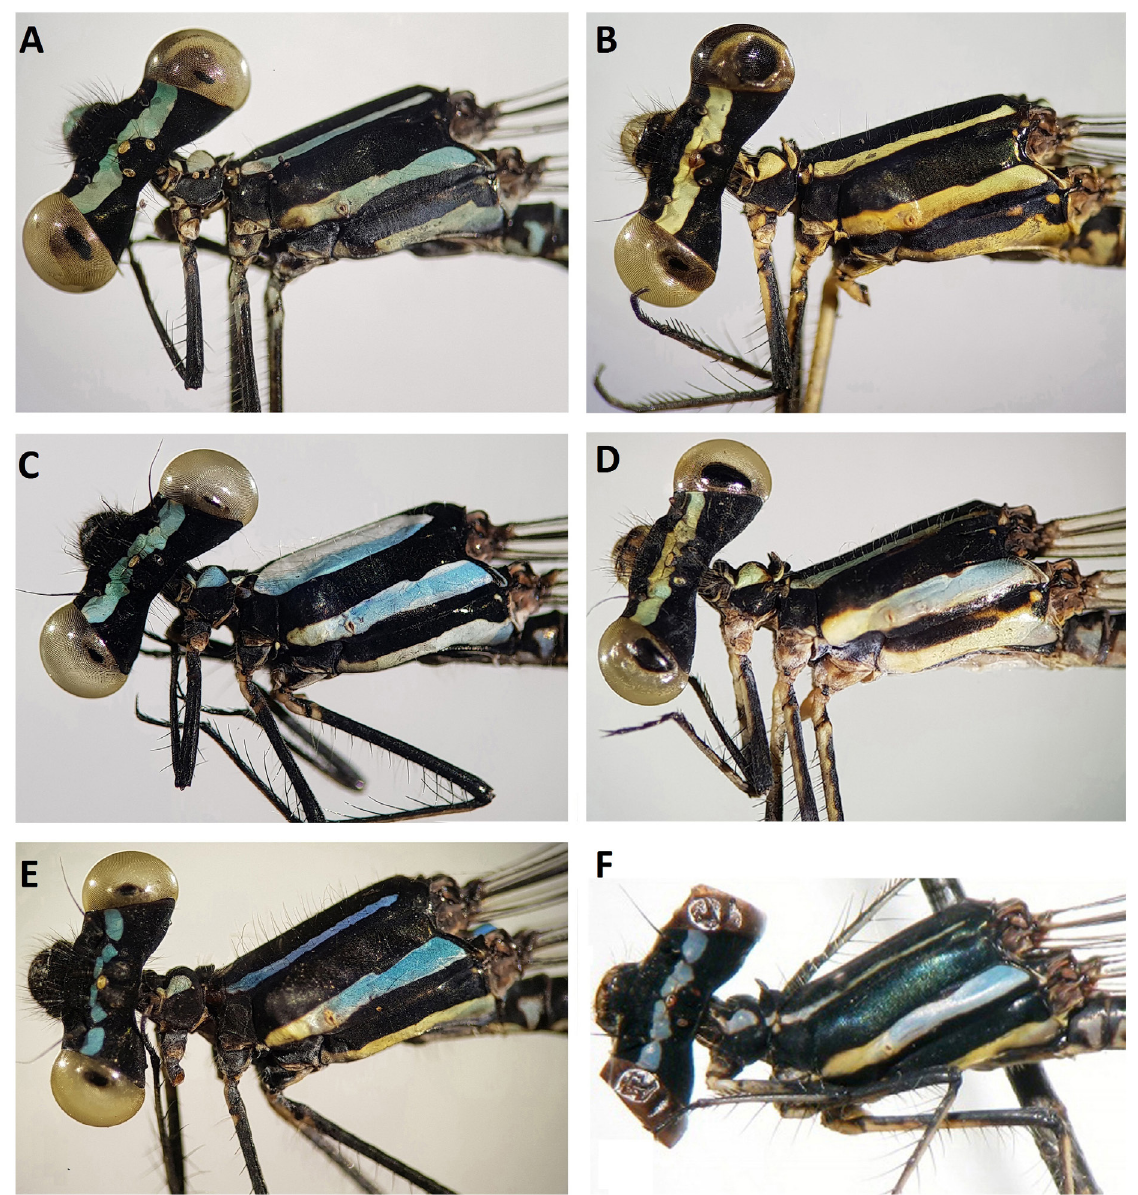
Fig. 2. Prodasineura Colwey, 1934 spp., head and thorax, lateral view (A, C, E: ♂, B, D, F: